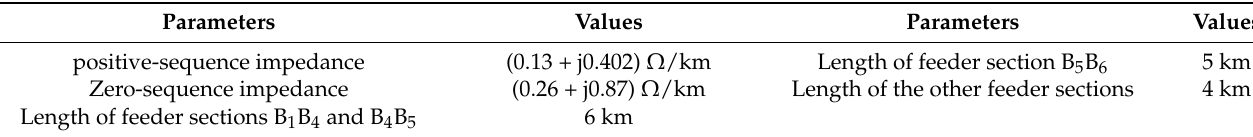
Table 2. Parameters of